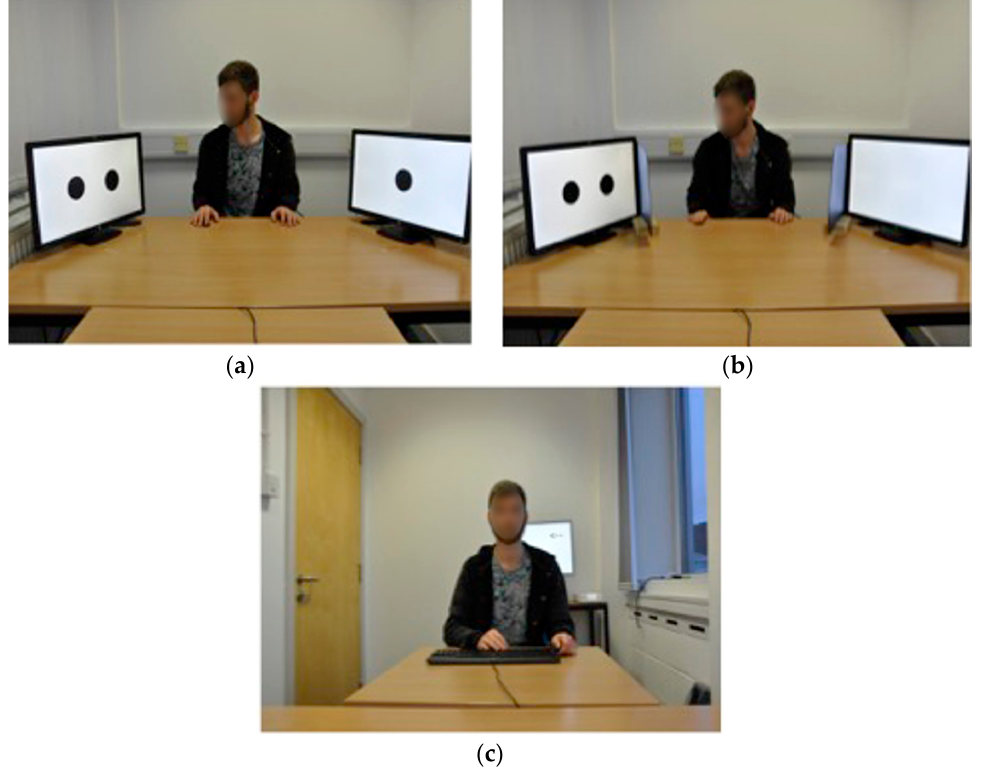
Figure 3. The arrangement of the apparatus used in Experiment 2: ( a ) from the point of view of a participant in the “seeing” condition; ( b ) from the point of view of a participant in the “non-seeing” condition; ( c ) from the point of view of the gazer where an arrow cue instructing the gazer to direct his gaze to the left can be seen above the participant’s left shoulder.